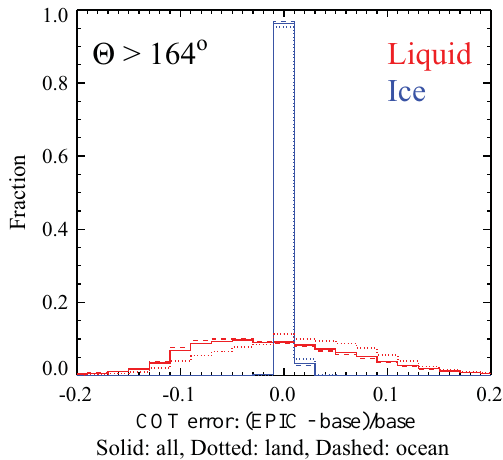
Figure 8. The distribution of relative single-channel COT retrieval errors with respect to the baseline two-channel COT-CER retrievals for liquid (red lines) and ice (blue lines) phase clouds for the entire April 2005 Aqua MODIS granule subset. As in Fig. 7b, the retrieval errors are for the pixel subset having scattering angle greater than 164 ◦ (see Fig. 1). Retrievals over all surfaces, land, and ocean are plotted as solid, dotted, and dashed lines,